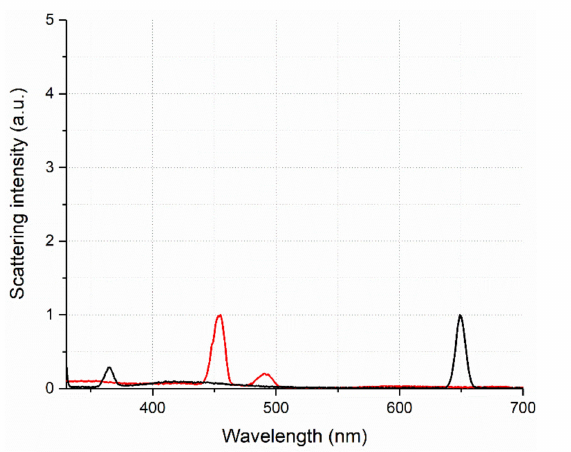
Figure 5. Water scattering signal, red— λ ex = 225 nm, black— λ ex = 325